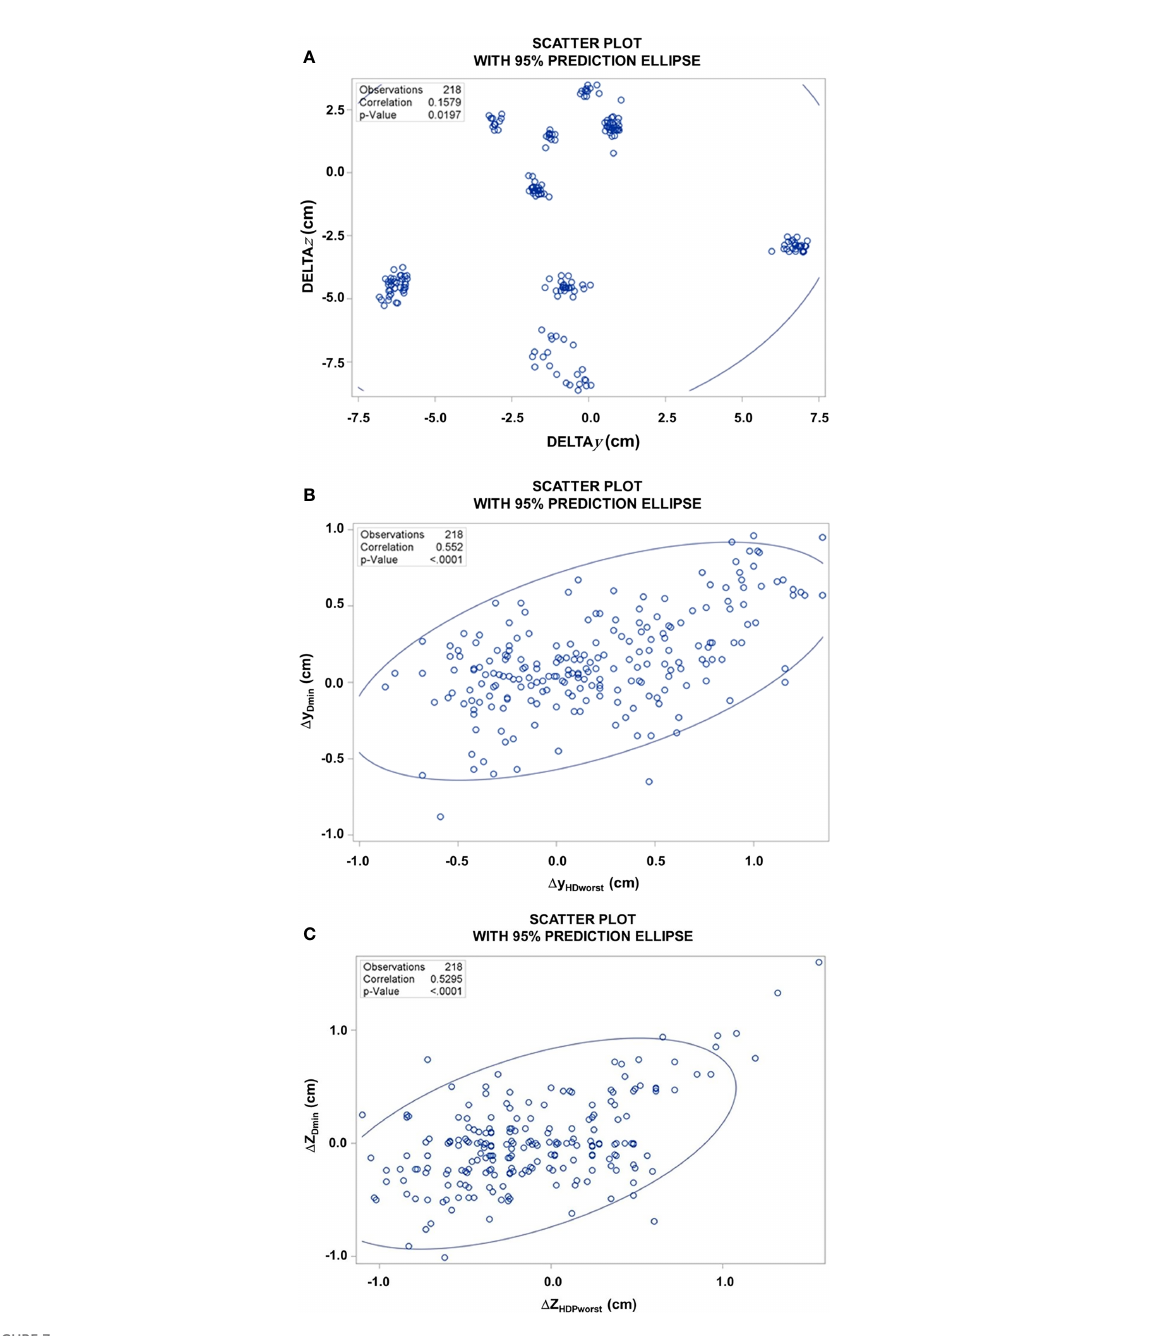
FIGURE 7 (A) Scatter plot of the difference of the z- coordinates of PD min_global_i and HDP worst_i, versus the respective difference of the y -coordinates over all 218 fractions from the 10 patients, DELTA z [Z HDPWorst – Z PDmin_global ] and DELTA y [Y HDPWorst – Y PDmin_global ]. (B) Scatter plot of the y- coordinates of the deformation vectors at of PD min_global_i versus HDP worst . (C) Scatter plot of the z-coordinates of the deformation vectors at PD min_global_i versus HDP worst over all 218